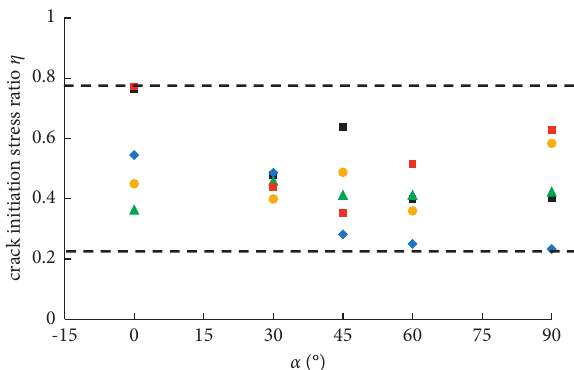
Figure 6: Distribution diagram of crack initiation stress ratio η